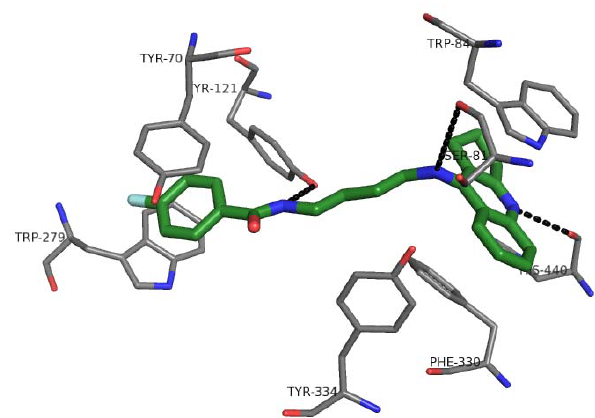
Figure 6. The binding mode of compound 27 into the active site of